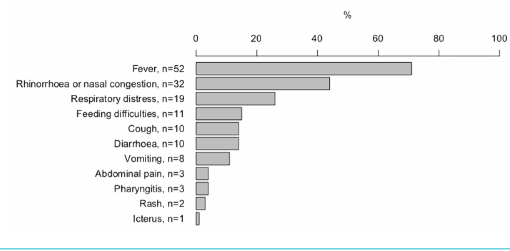
Table 2: Investigations in neonates with SARS-CoV-2 infection. Nasopharyngeal swab for other